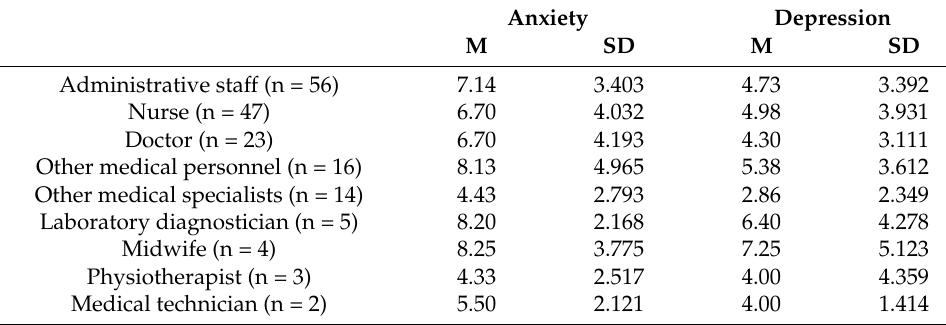
Table 1. HADS scale results for selected occupational groups.